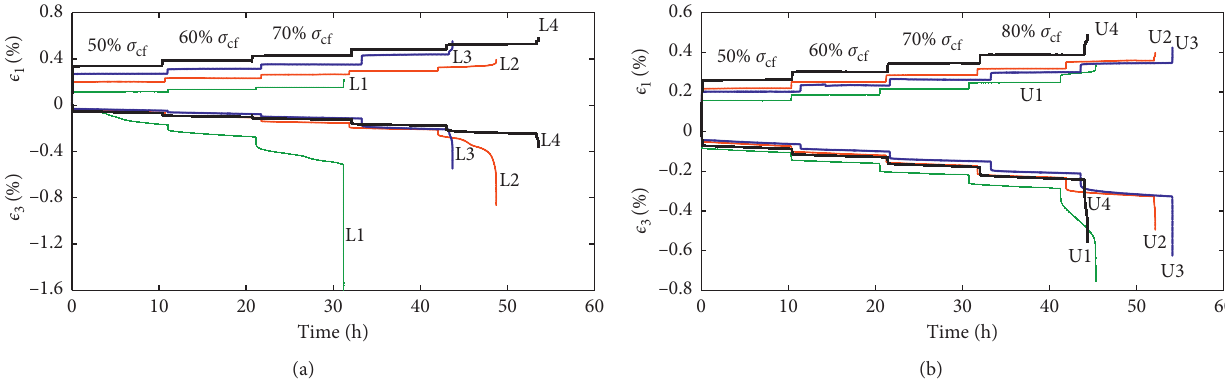
Figure 2: Variation of axial strain and lateral strain of cracked rock in creep tests. (a) Loading-cracked samples. (b) Unloading-cracked